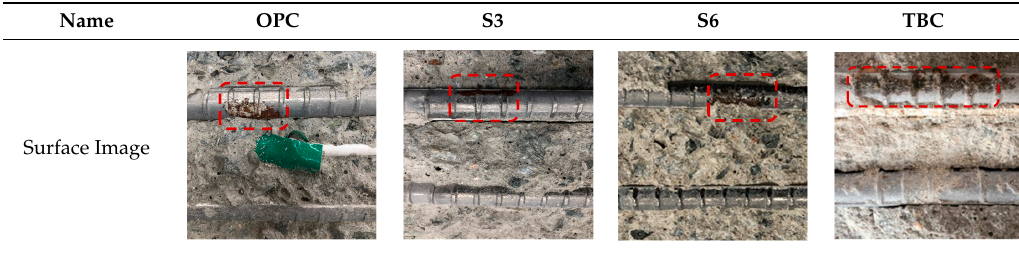
Figure 10. Result of OCP monitoring on NaCl supply time ( a ) OPC, ( b ) S3, ( c ) S6, ( d ) TBC. Table 7. Surface image of rebar after OCP monitoring experiment.